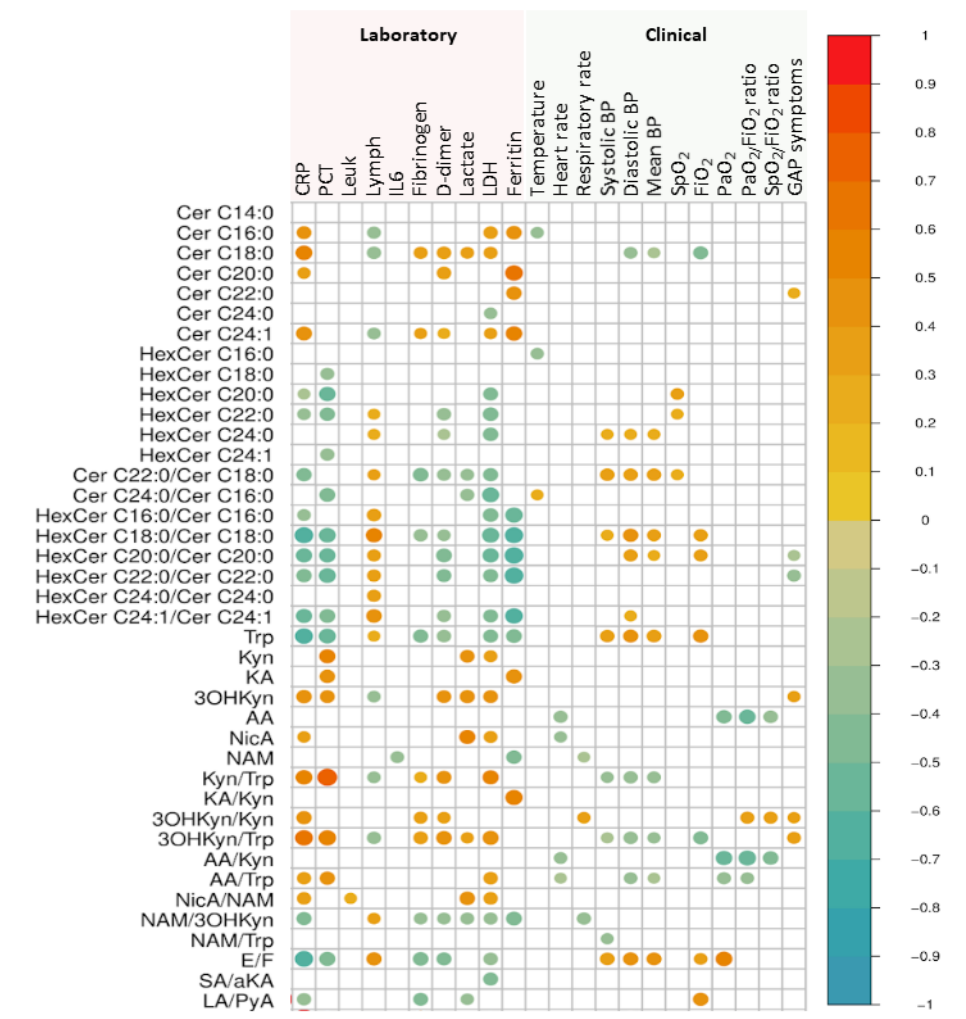
Figure 5. Clinical and laboratory correlates with metabolomics. Correlation plots illustrate Pearson correlations between plasma biomarkers (after log transformation) and clinical/laboratory parameters. Positive statistical significant correlations are shown in red circles and negative statistical significant correlations are shown in blue circles. The circle size represents the magnitude of the individual correlation. Abbreviations: AA: anthranillic acid; aKA: α -ketoglutarate; BP: blood pressure; Cer: ceramide; CRP: C-reactive protein; E: cortisone; F: cortisol, GAP: days from first symptom until inclusion; HexCer: hexosylceramide; 3OHKyn: 3-hydroxykynurenine; IL6: interleukin 6; KA: kynurenic acid; Kyn: kynurenine; LA: lactate; LDH: lactate dehydrogenase; Leuk: leukocytes; Lymph: lymphocytes; NAM: nicotinamide; NicA: nicotinic acid; PCT: plateletcrit; PyA: pyruvic acid; SA: succinic acid; Trp: tryptophan.